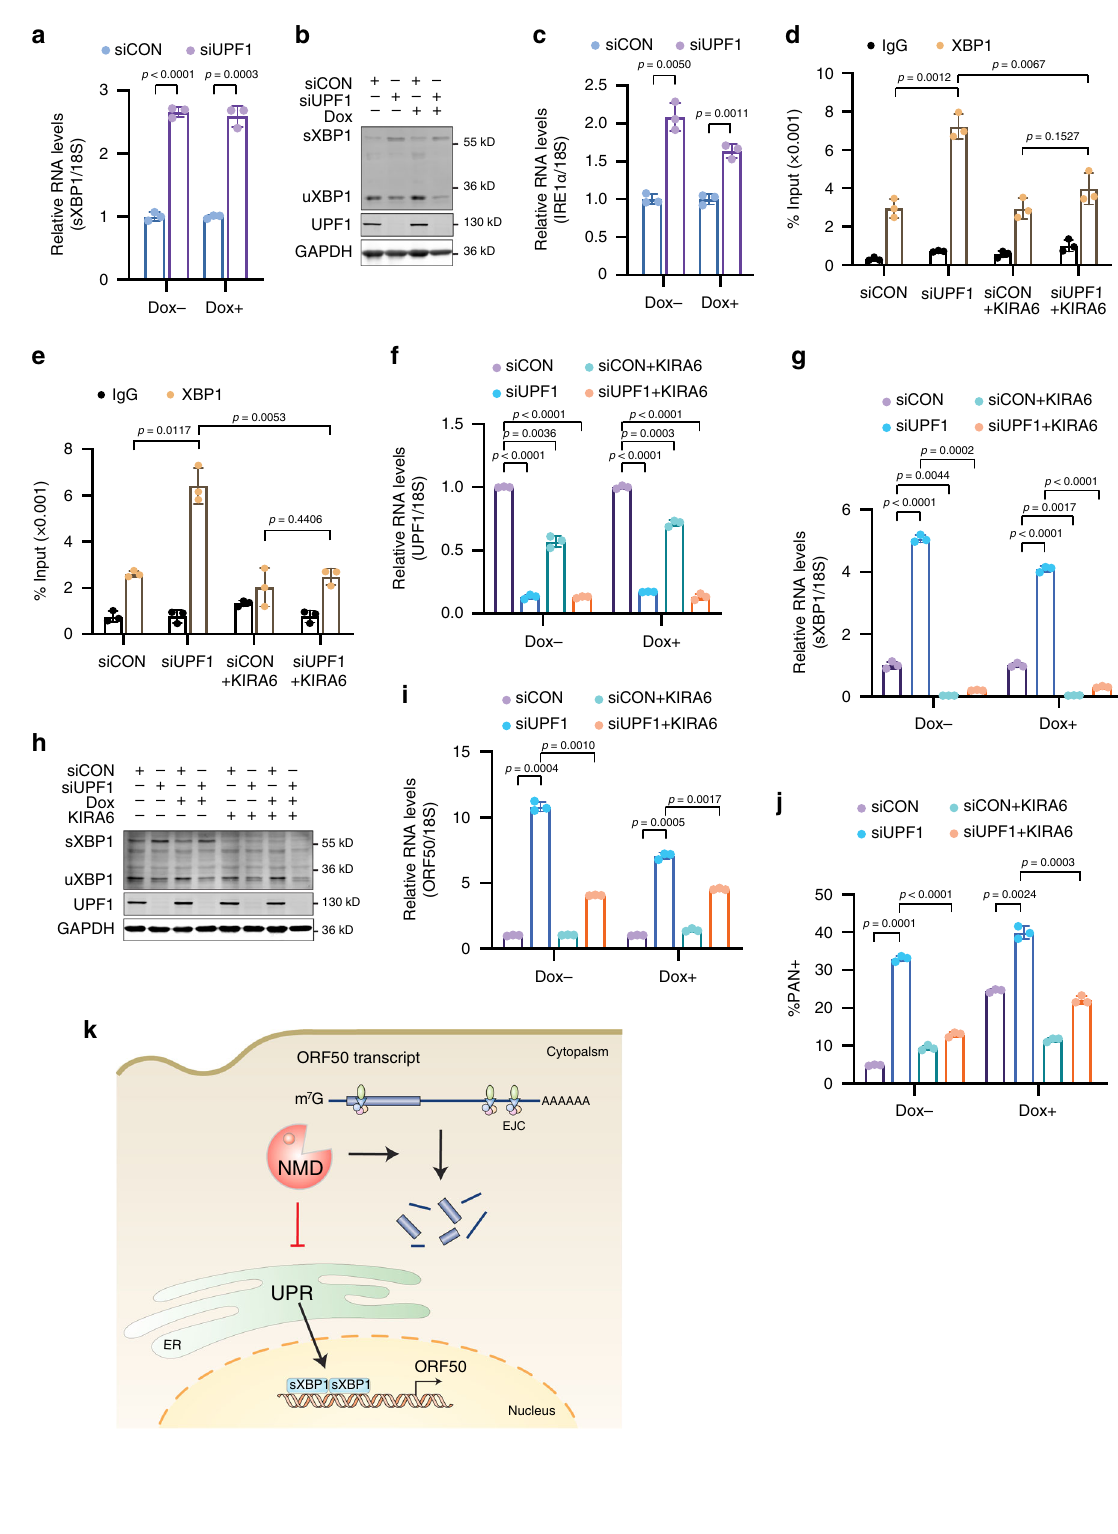
are present within protein coding ORFs as well as in the 3 ′ UTR of the 5 ′ proximal gene in polycistronic RNAs. For example, the intron we validated in the ORF46 coding sequence is simulta- neously positioned within the 3 ′ UTR of ORF48. The presence of an intron with an RNA affords additional opportunities for the